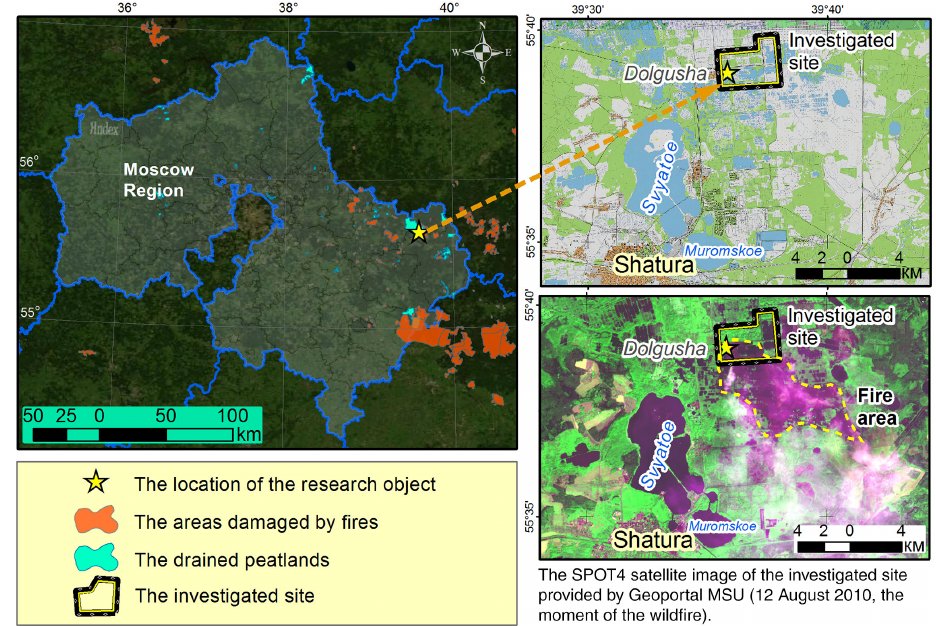
Figure 1. The location of the research site.